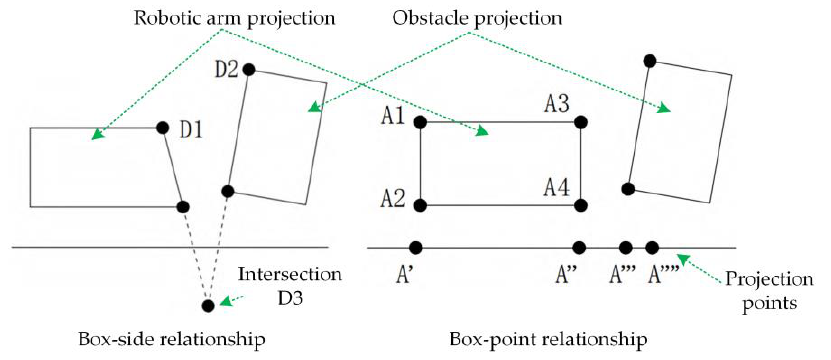
Figure 3. Obstacles modeling representation in 2D and 3D space.